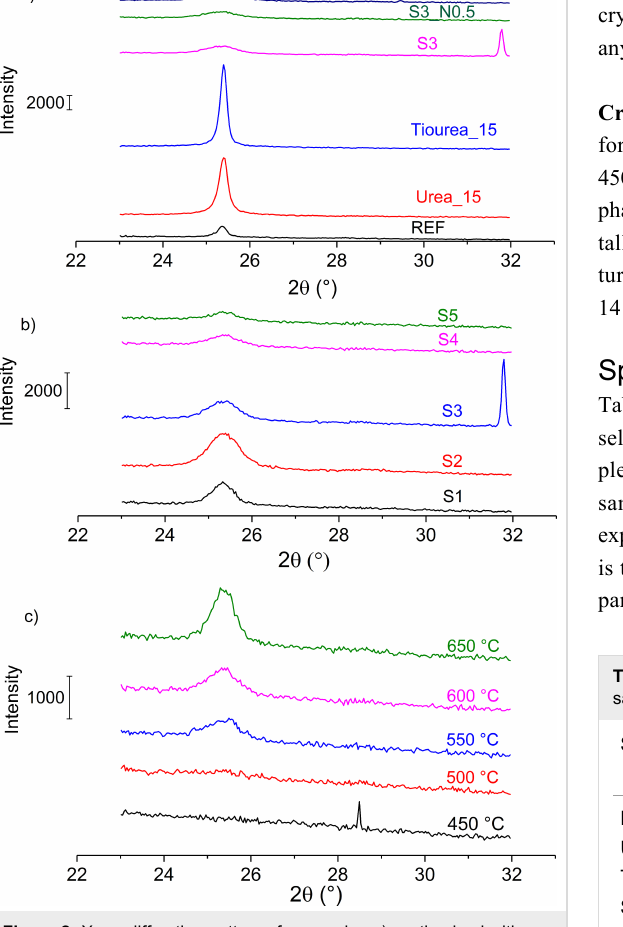
Figure 2: X-ray diffraction patterns for samples a) synthesized with HCl, b) samples S1–S5, and c) the crystallization process of sample S4.